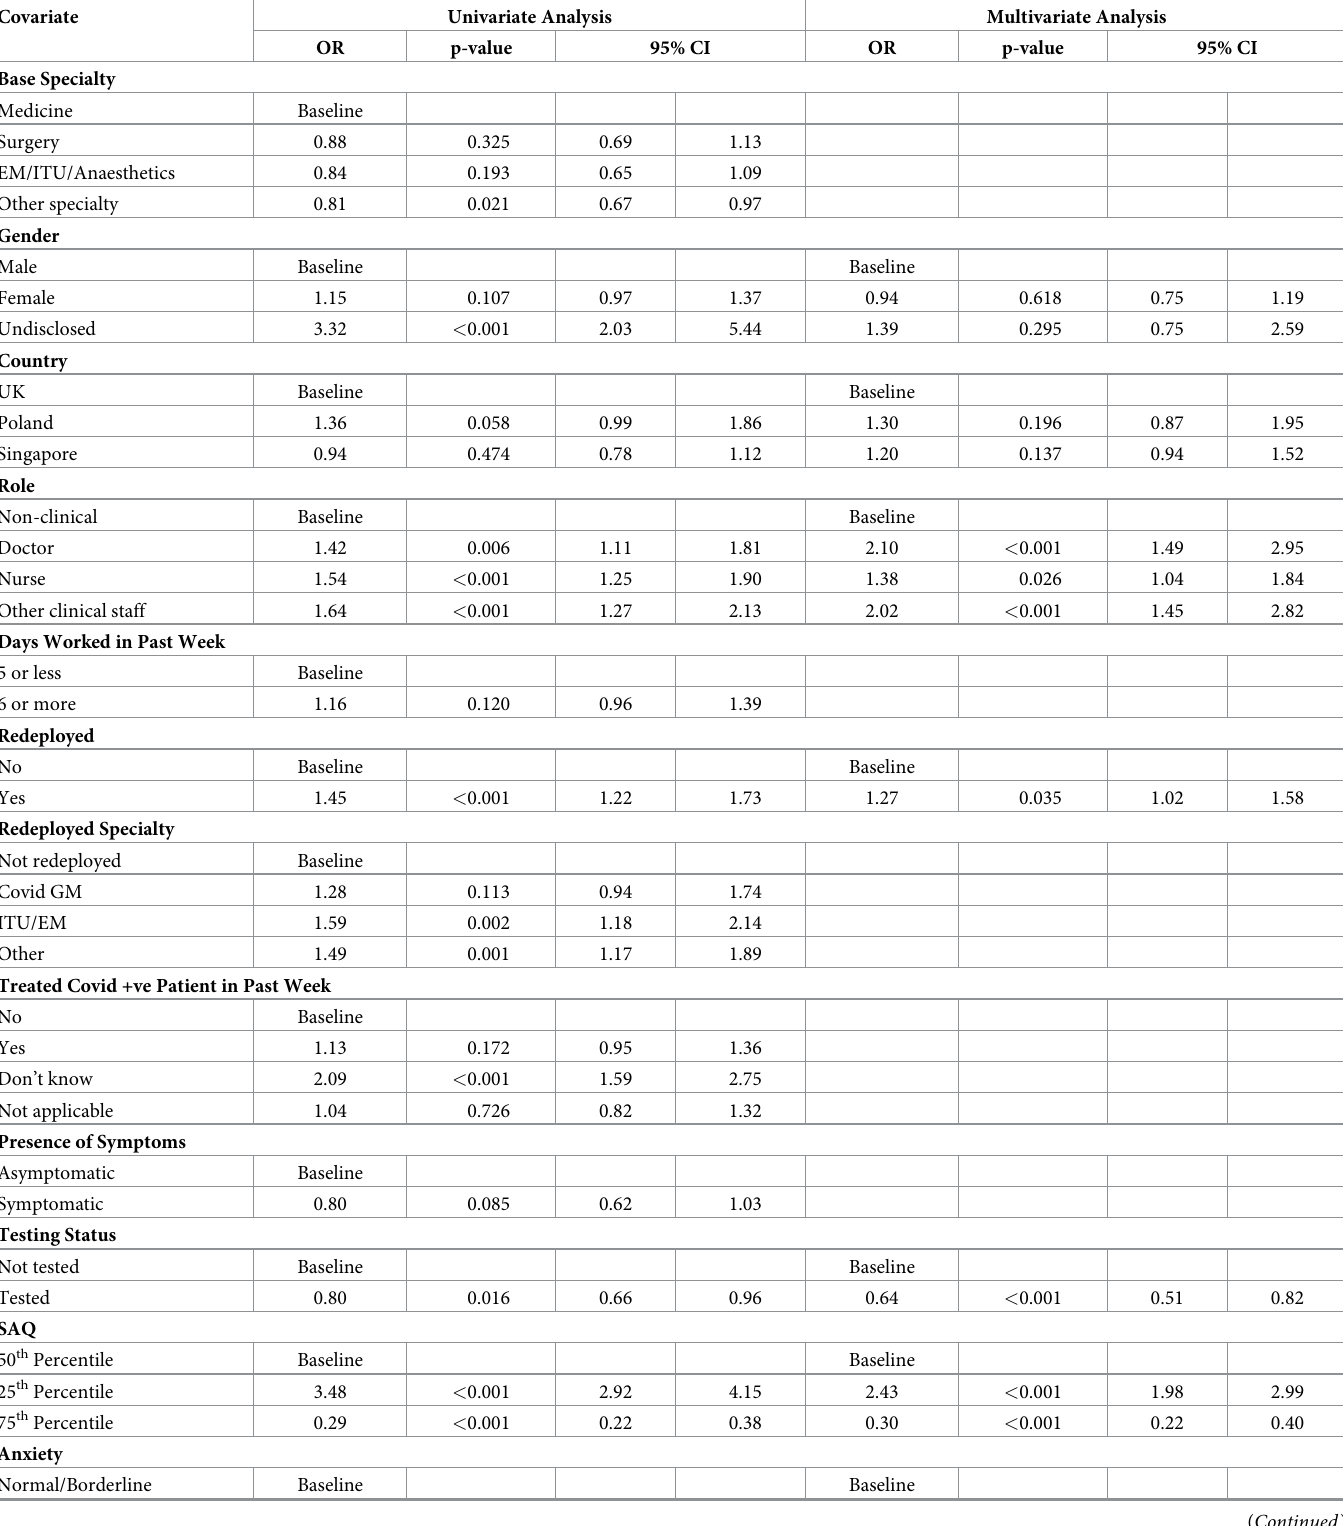
Table 3. Logistic regression analysis with burnout as dependent